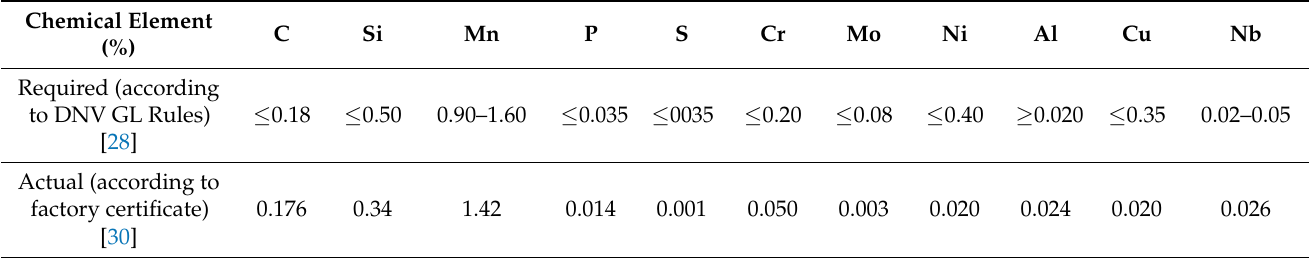
Table 1. Chemical composition of the base material used in the